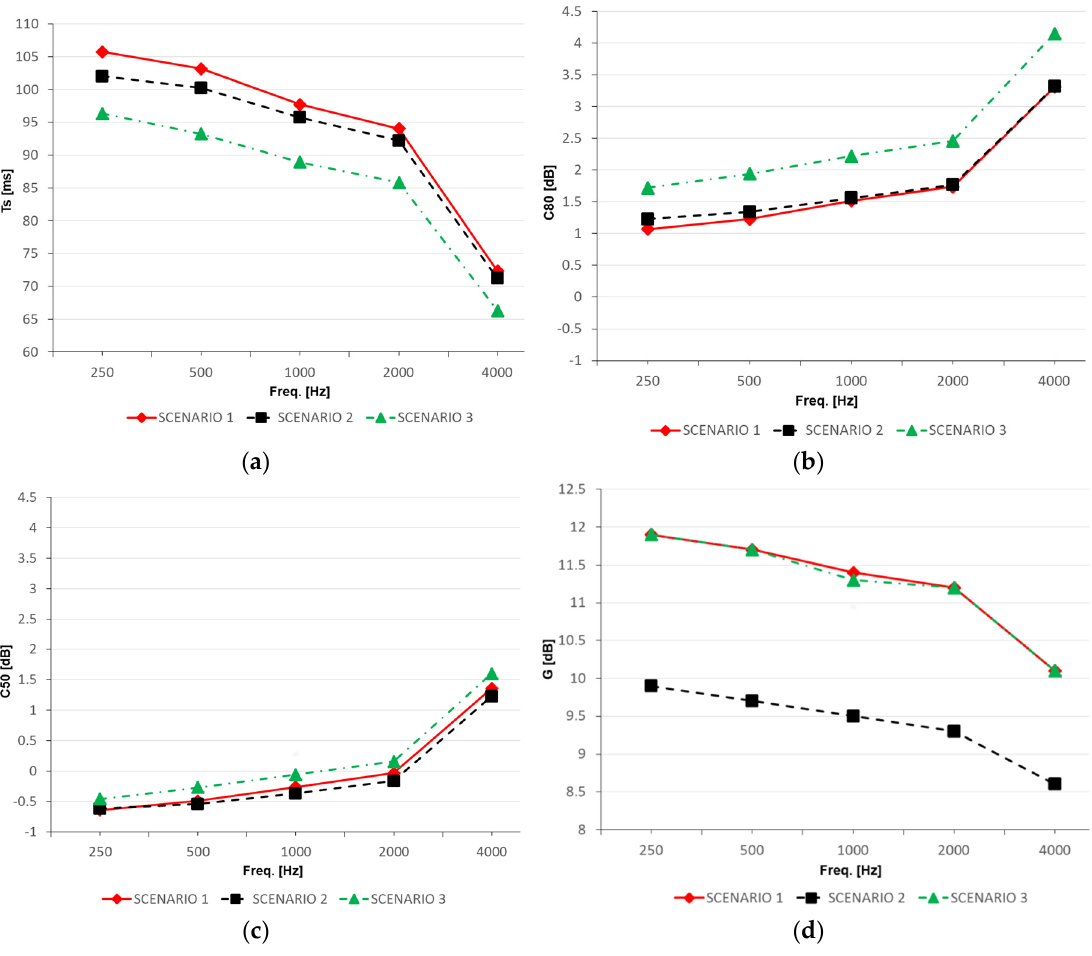
Figure 10. Averaged values of the simulated acoustic parameters ( a ) Ts, ( b ) C80, ( c ) C50, and ( d ) G for the theatre in Scenario 1 (empty theatre), Scenario 2 (with the audience), and Scenario 3 (3D model reconstructed according to the plan dated 1784 in unoccupied condition).